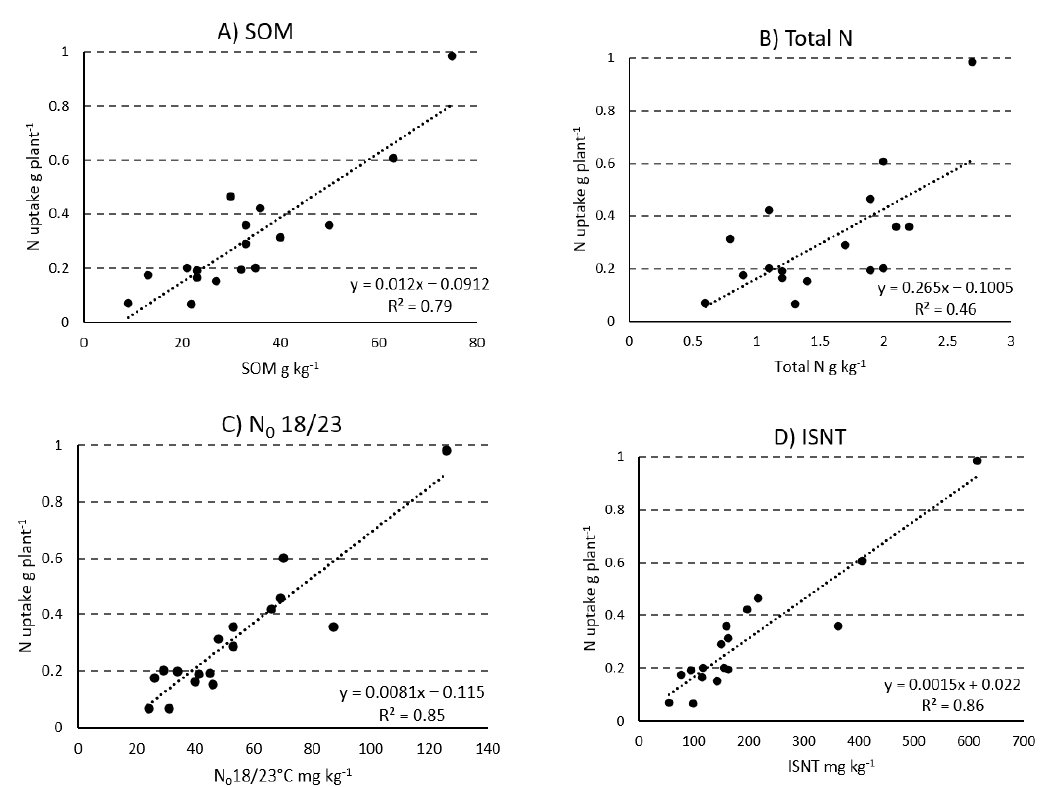
Figure 1. Linear relationship between total N uptake by maize ( Zea mays L.) and soil organic matter ( A ), soil total N ( B ), potentially available N estimated by aerobic incubation at 18/23 °C ( C ), and the Illinois Soil Nitrogen Test ( D ).